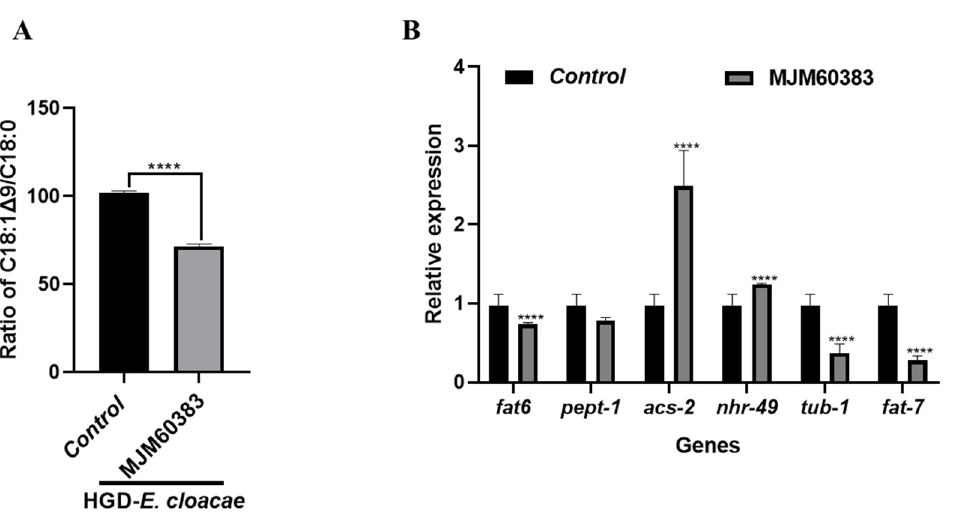
Figure 5. MJM60383 altered fatty acids composition and fat metabolism-related gene expression. ( A ) The desaturation index was measured by the ratio of C18:1 Δ 9/C18:0 (n = 3 samples, each sample containing 5 mg of lipid). ( B ) The relative expression level of fat metabolism-related genes. Data are expressed as the mean ± SD. Statistically significant differences between the treated group and control group were analyzed using the one-way ANOVA with Dunnett’s multiple comparison tests (**** p < 0.0001, compared with the HGD- E. cloacae group).